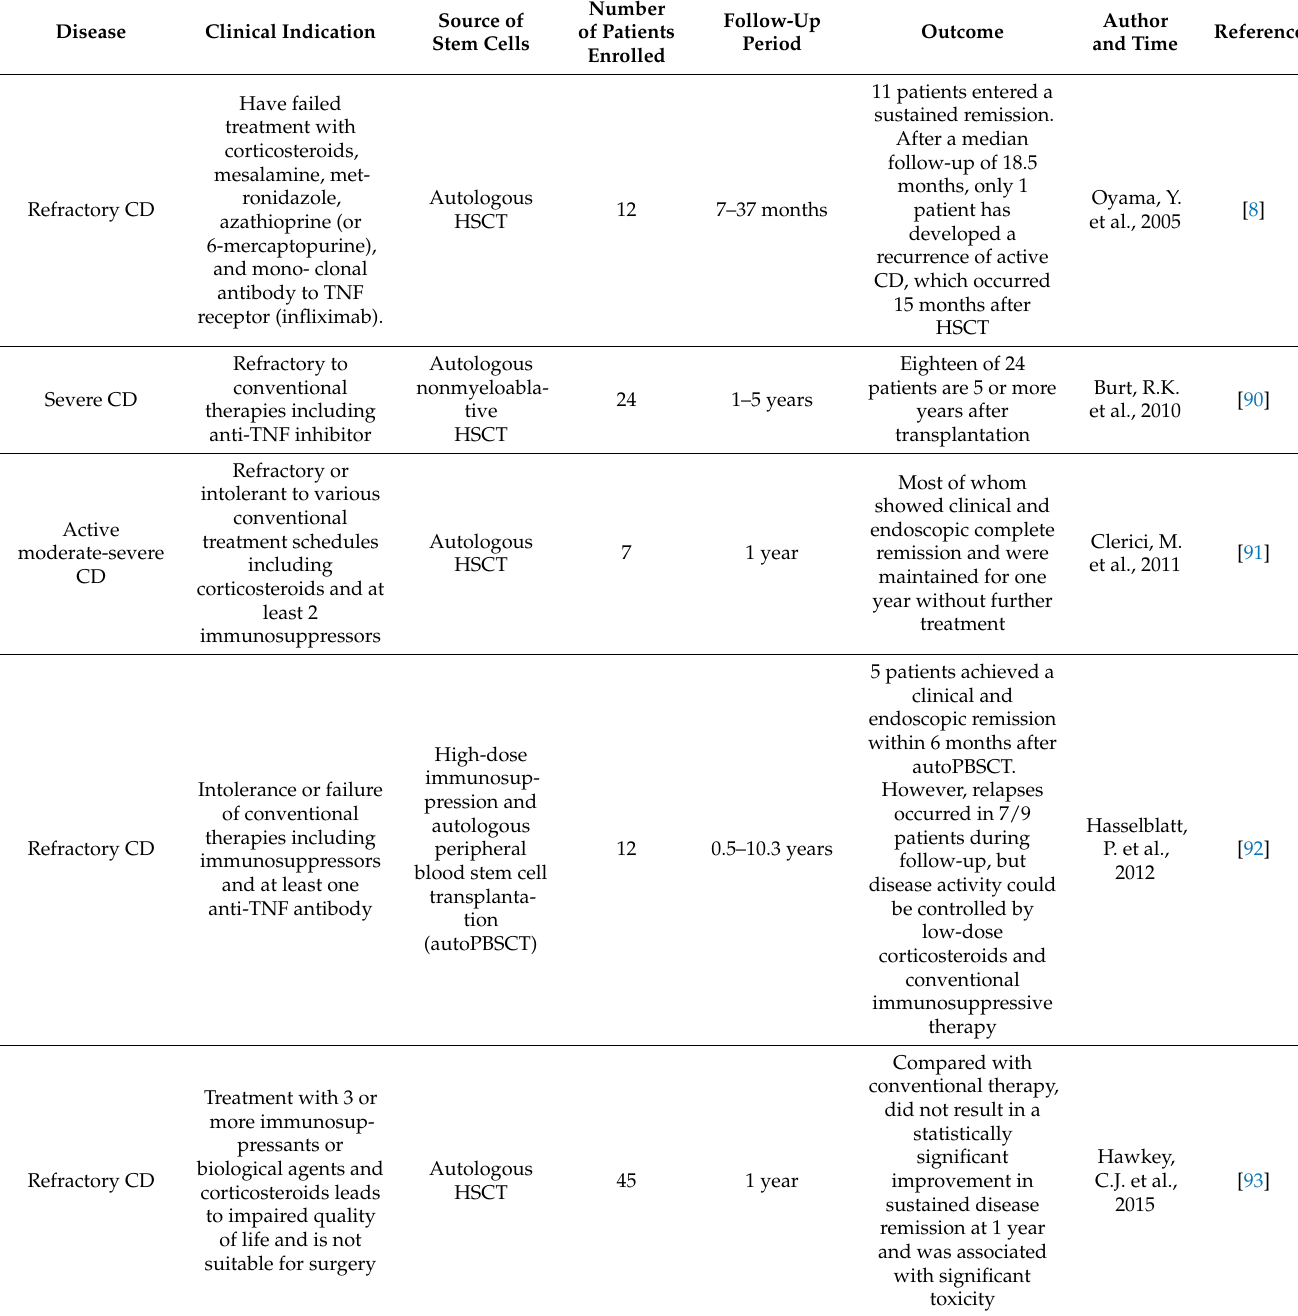
Table 4. Clinical trials in stem cell-based therapies for Inflammatory Bowel